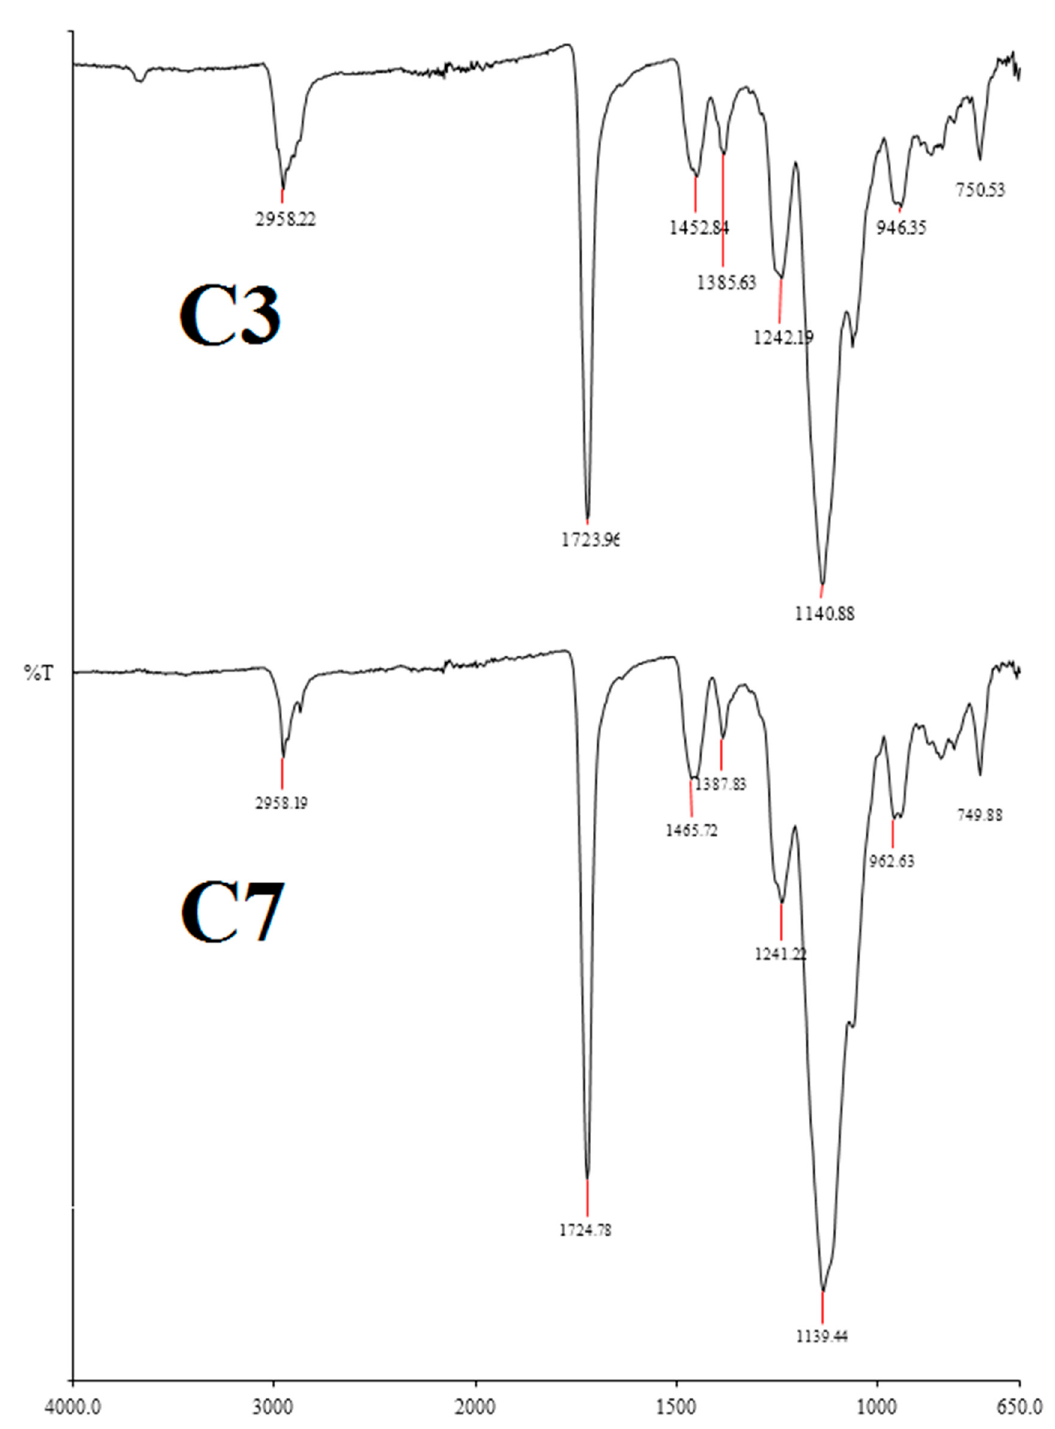
Figure 2. FT-IR spectra of the columns: Column 3 and Column 7.